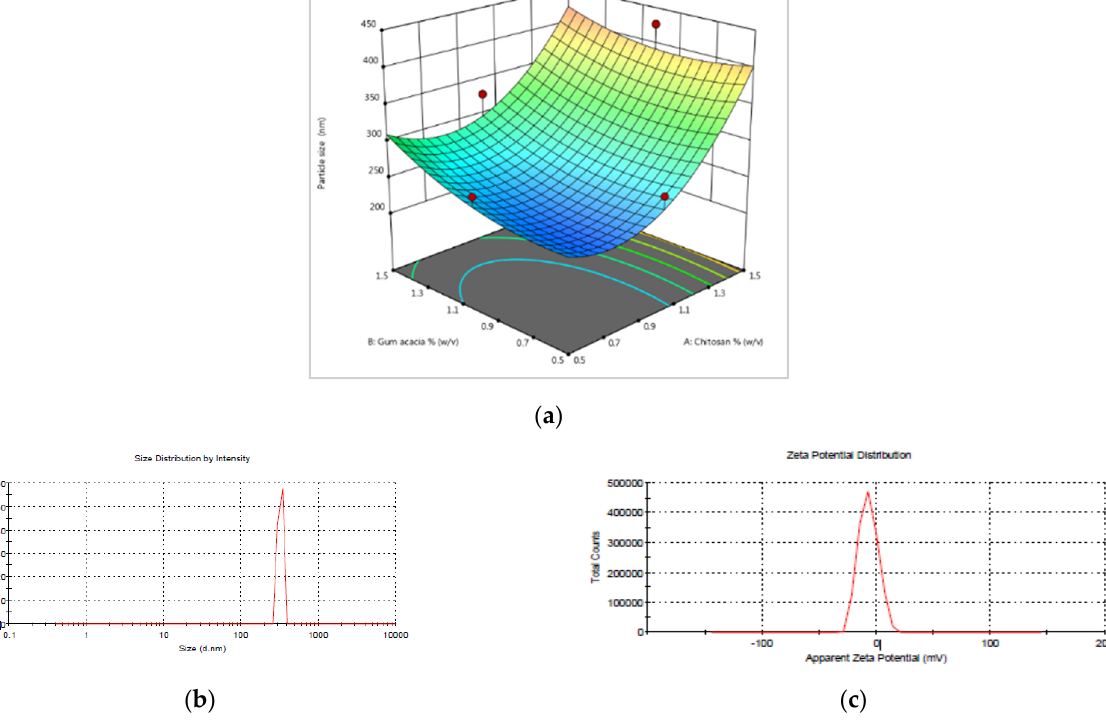
Figure 1. ( a ) Optimization of the concentration of gum acacia and chitosan for the particle size by response surface methodology (RSM); ( b ) mancozeb-loaded NP size; ( c ) mancozeb-loaded NP zeta potential.